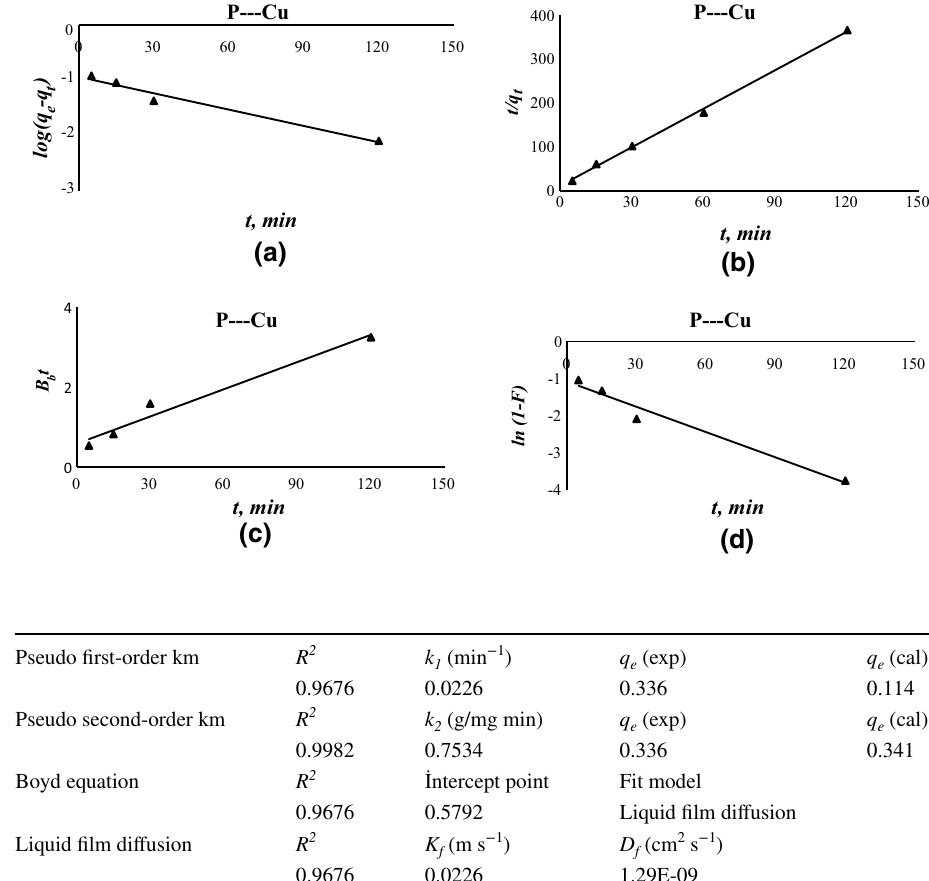
Table 2 Kinetics model data